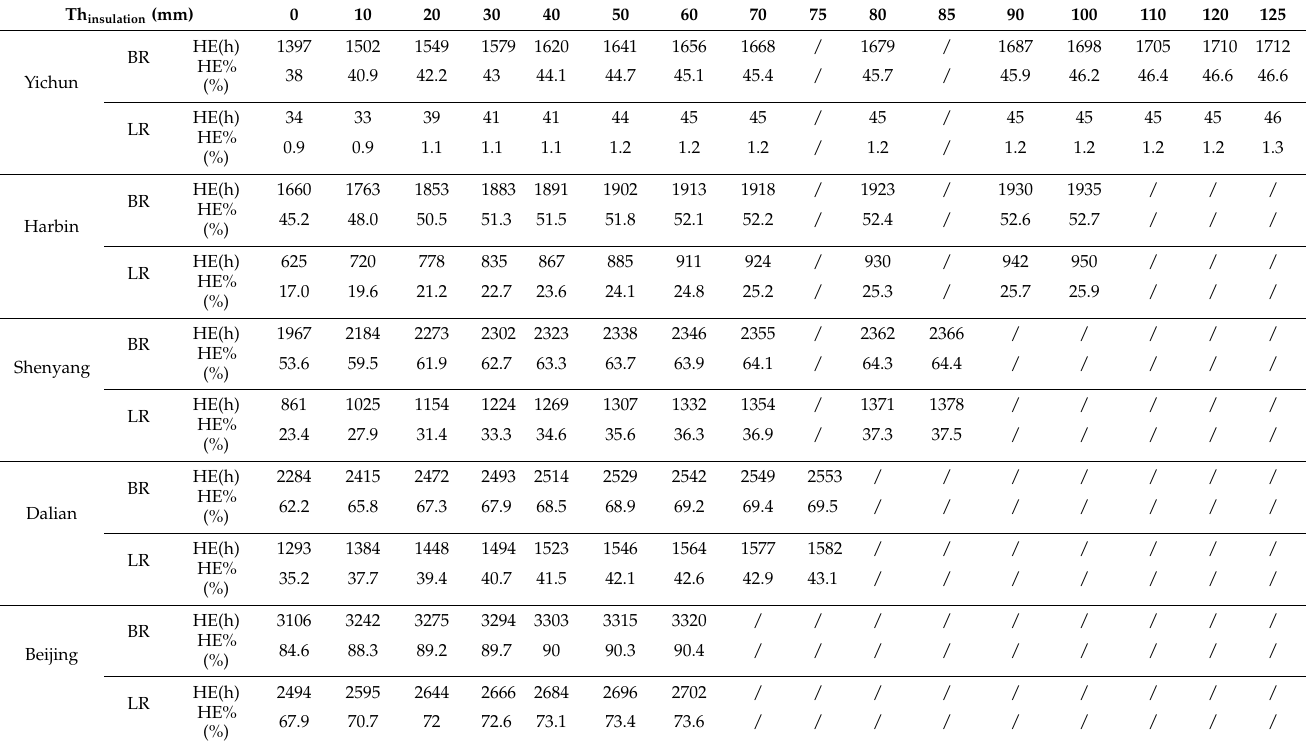
Table 9. Overheating duration with Th insulation as variable in the simulated flats (on the 7th floor) of each representative city during summertime over 15 years (2004 to